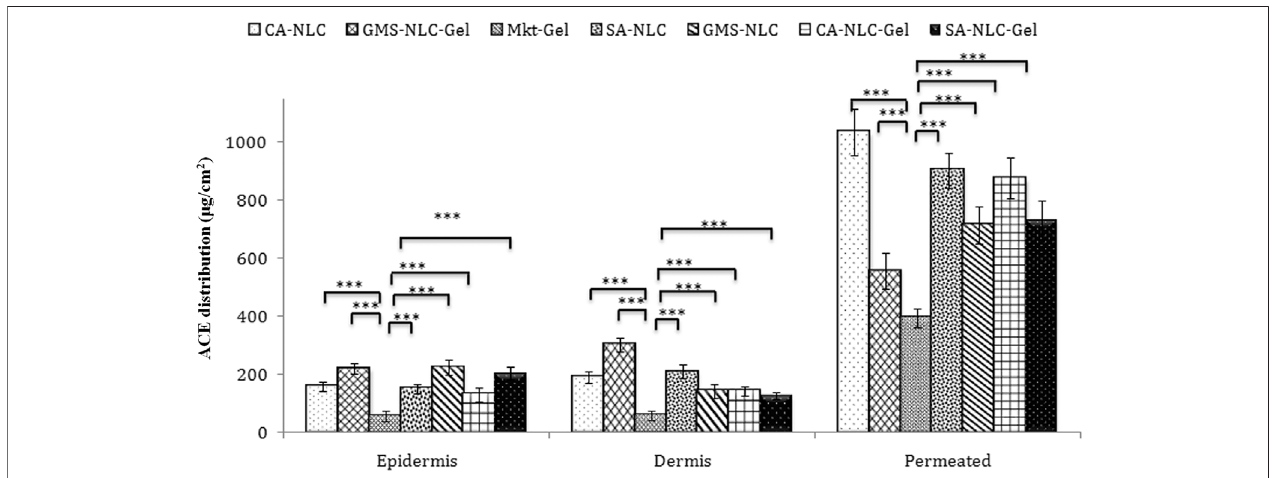
FIGURE7| AssessmentofACEdistributionacrosstheskinlayers(epidermisanddermis)andquanti fi cationofACEpresentintheepidermisanddermis,toquantify the total drug permeated using different formulations (CA-NLC, SA-NLC, SA-NLC-gel, GMS-NLC, CA-NLC-gel, GMS-NLC-gel, and Mkt-gel). Statistical data are expressed as * p < 0.05 (signi fi cant), ** p < 0.01 (moderate signi fi cant), and *** p < 0.001 (highly signi fi